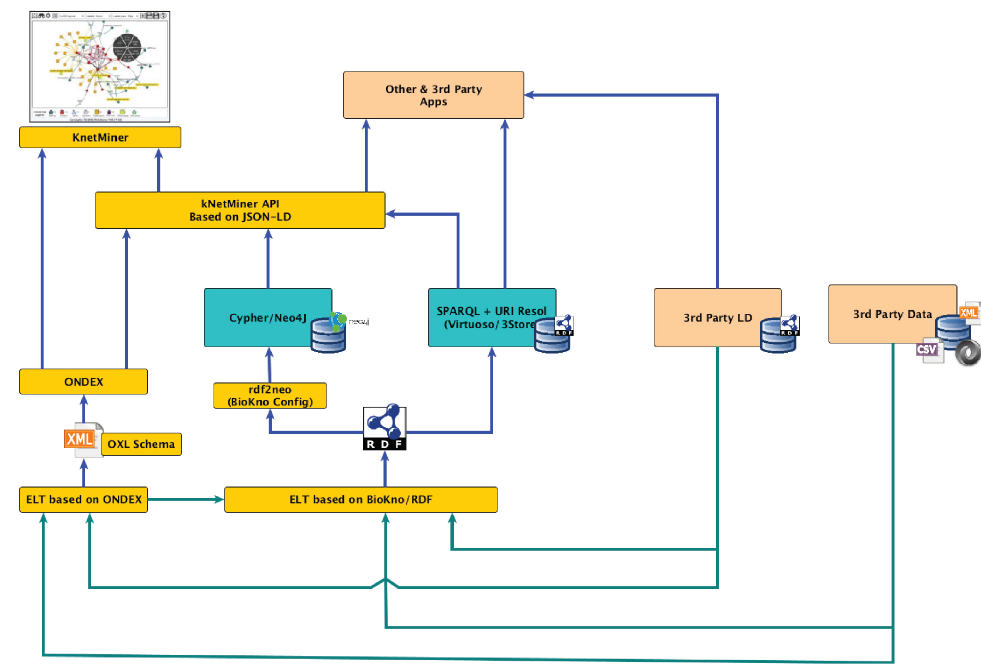
Figure 2: The new architecture designed for the KnetMiner ecosystem. BioKNO-based modelling powers both data acquisition (extraction, loading, transformation, or ELT) and data querying from our and 3rd-party applications. RDF serves open data publishing and integration with other data